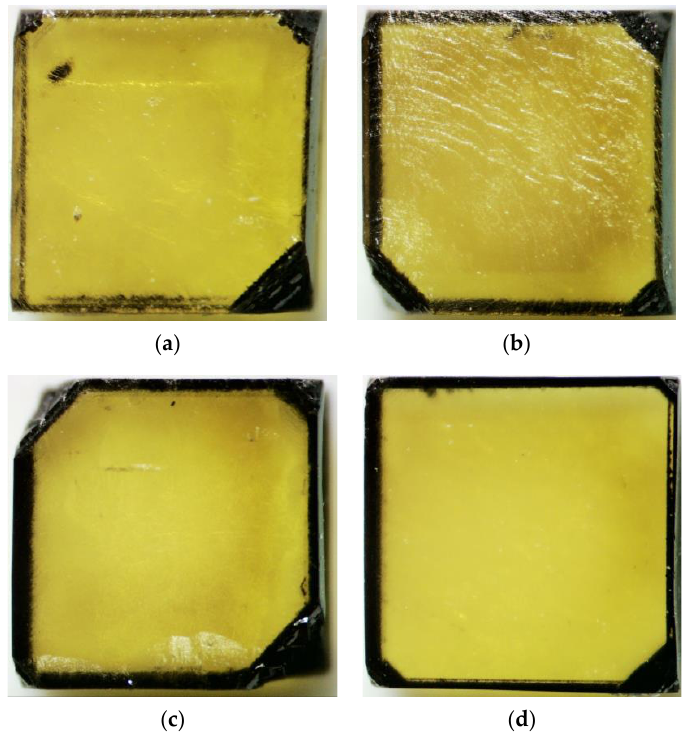
Figure 5. Optical images of as-grown MWPACVD diamonds on top of HPHT type Ib seed substrates with different CH 4 gas concentration: ( a ) 6%, ( b ) 8%, ( c ) 10%, and ( d ) 12%. SEM analyses were employed to identify in detail some features of the striations formed by the step-growth regime of the films. It is noticeable in the obtained micrographs (Figure 6), that as well as the formation of steps, some square-shaped features are present (Figure 6a – c). This is related to the growth of the steps in a screw pattern centered at dislocations present in the crystal [18].